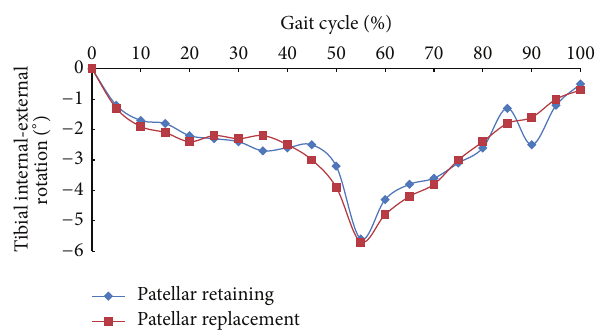
Figure 4: Tibial internal-external rotation for patellar retaining and replacement